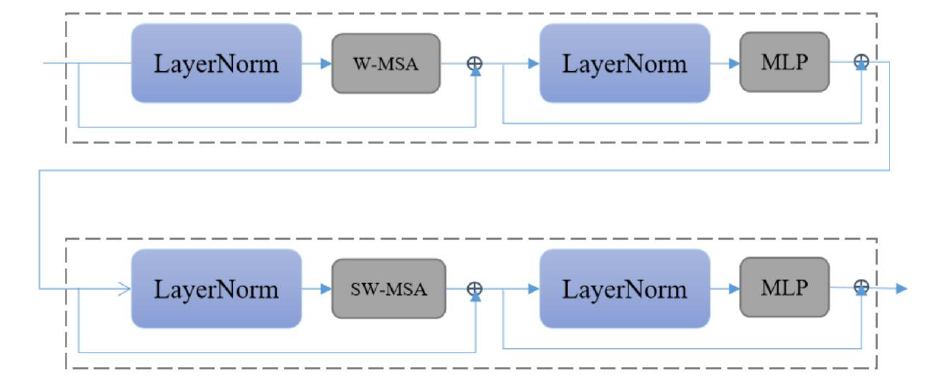
Figure 11. Two successive Swin Transformer layers. W-MSA is window self-attention mechanism. SW-MAS is shifted window self-attention mechanism.